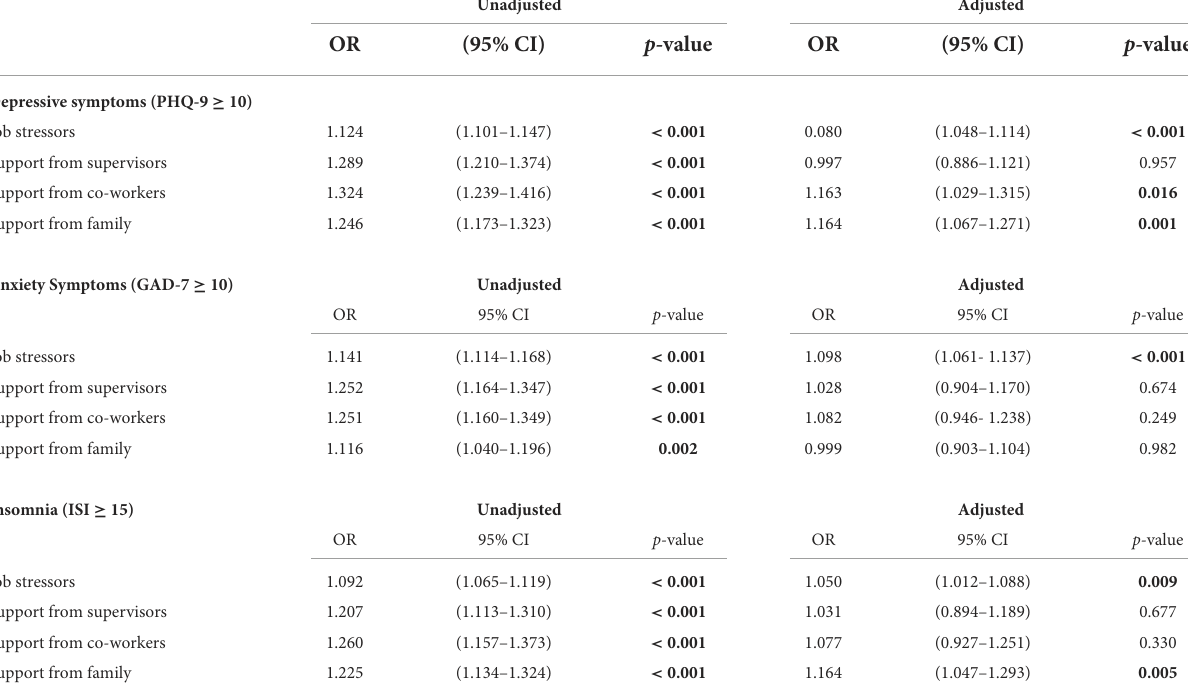
TABLE 3 Logistic regression analysis of depressive symptoms, anxiety symptoms, and